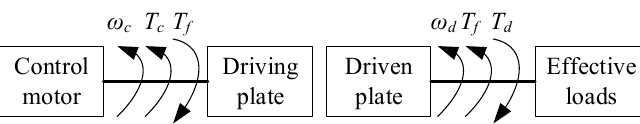
Figure 5. Schematic diagram of the power transmission system of the centrifuge.